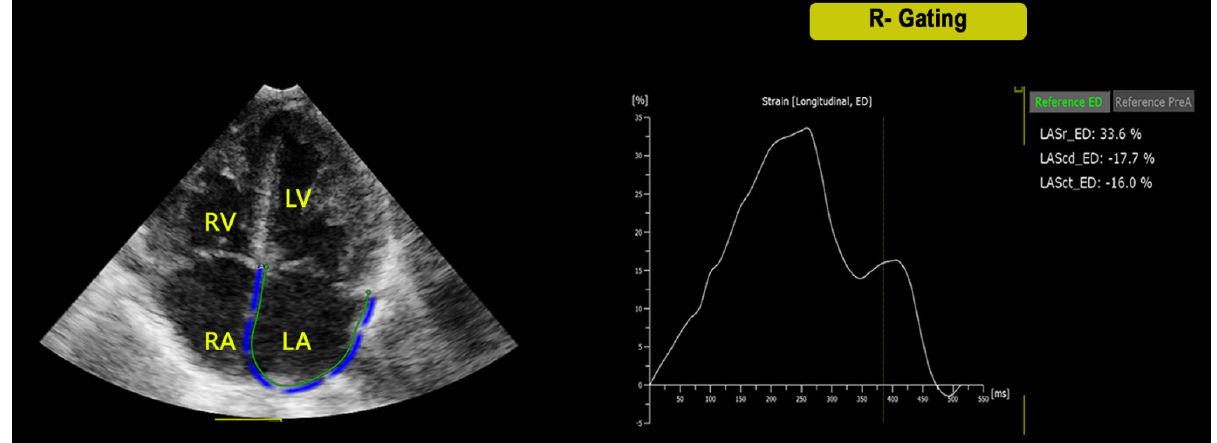
Figure 2. Left atrial ε analysis in the four-chamber view by using the atrial specific software for strain STE analysis with R-gating method. LA = Left atrium, LV = Left Ventricle, RA = Right Atrium, RV = Right Ventricle, Sr = strain reservoir, Sct = strain contractile, Scd = strain conduit. The ejection fraction was calculated by the biplane Simpson method. Approval for this study was obtained from the Local Ethics Committee (Comitato Etico Meyer no. 62/2016). Parents or legal guardians of all the children were informed and provided written consent for participation in this study.